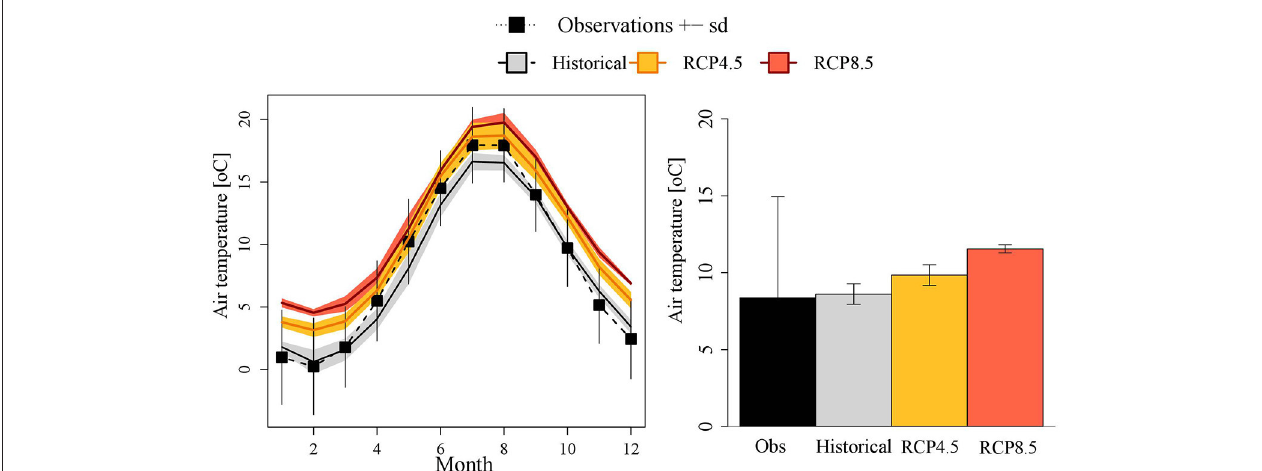
FIGURE 3 | Ensemble mean, monthly air temperature in 2 m height (in ◦ C ) at Gotland Deep (BY15) calculated from four regional climate simulations: historical period (1976–2005) (solid black line) and future period (2069-2098) according to RCP 4.5 and RCP 8.5 scenarios (solid orange and red lines, respectively). The colored shaded areas denote the range between minus and plus one standard deviation among the ensemble members. In addition, observations and their standard deviations are shown (black squares and vertical thin bars).